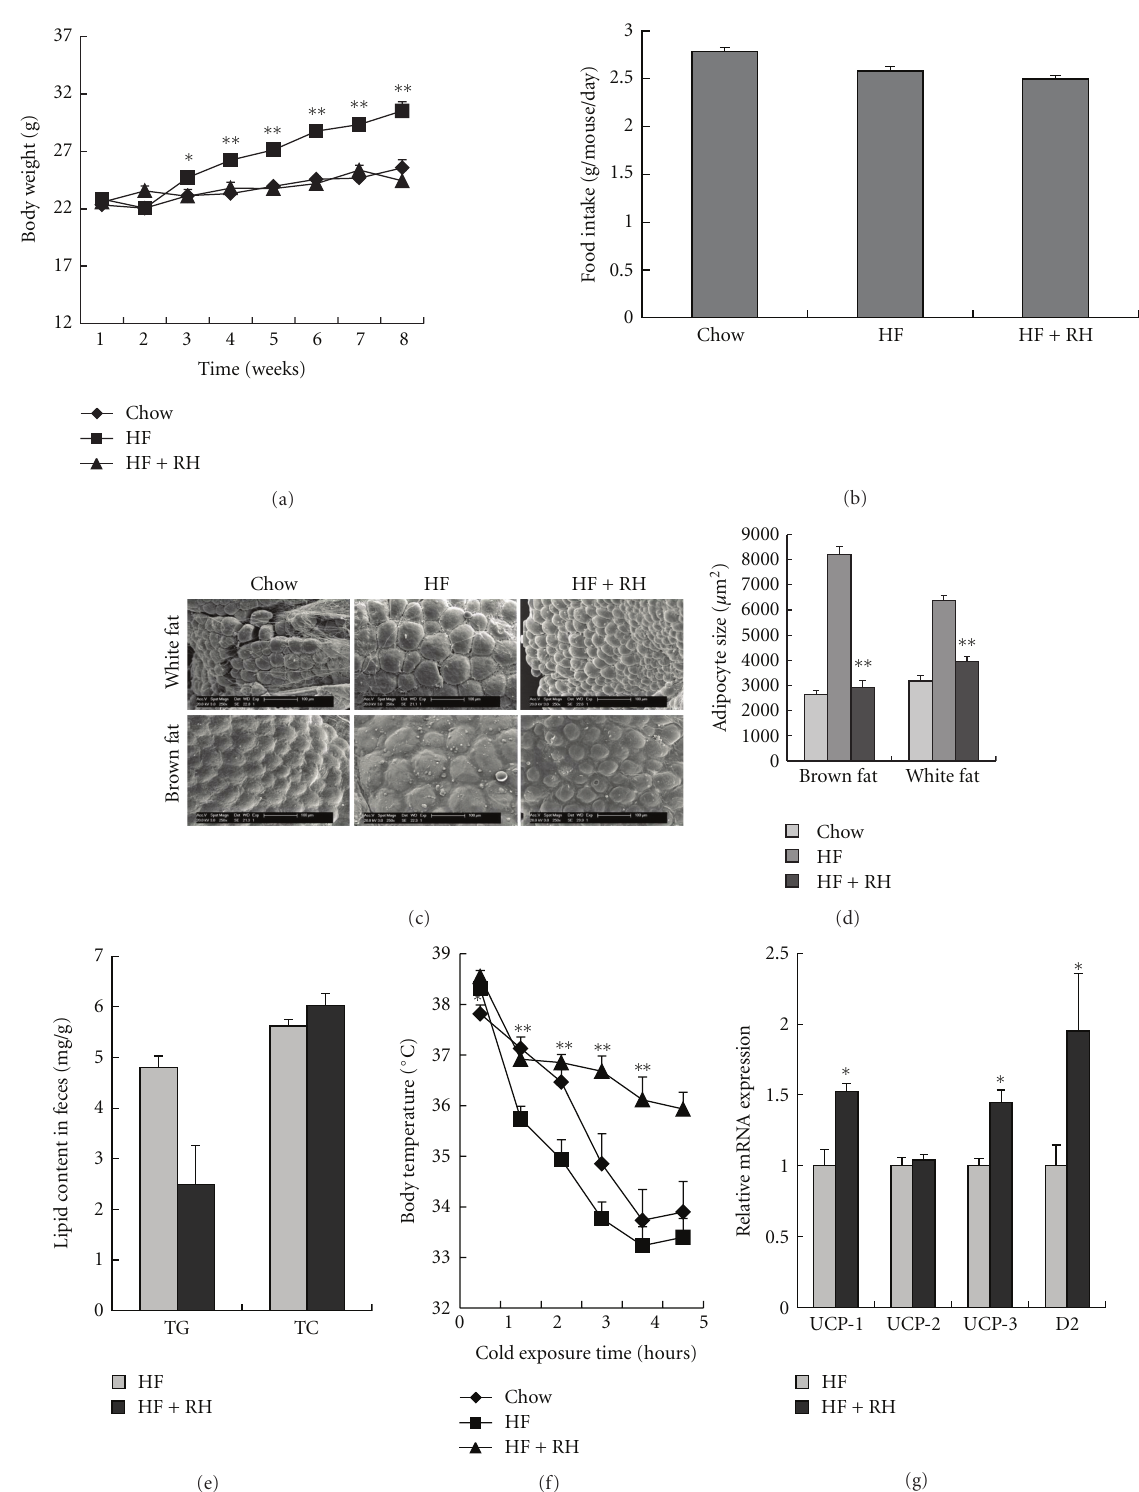
Figure 2: Rhein blocks body weight gain in high-fat diet-fed C57BL/6 mice. (a) Body weight. (b) Food intake amount. (c) The mass of white adipose tissue (WAT) and brown adipose tissue (BAT). (d) The adipocyte size of BAT and WAT in μ m 2 . (e) TG and TC content in feces. (f) Body temperature at di ff erent times after cold exposure (4 ◦ C). (g) The mRNA expression level of the thermogenic genes in BAT. β -actin was used as an internal control for modifying the mRNA level. Mice were fed a high-fat diet for 8 weeks and rhein was powdered and mixed in the diet at 0.1% (wt/wt). HF: high-fat diet. RH: rhein. The food intake amount was recorded every 2 days through the treatment. Values are mean ± SE for 7 mice per group. ∗ P < 0 . 05, ∗∗ P < 0 . 01 versus HF group